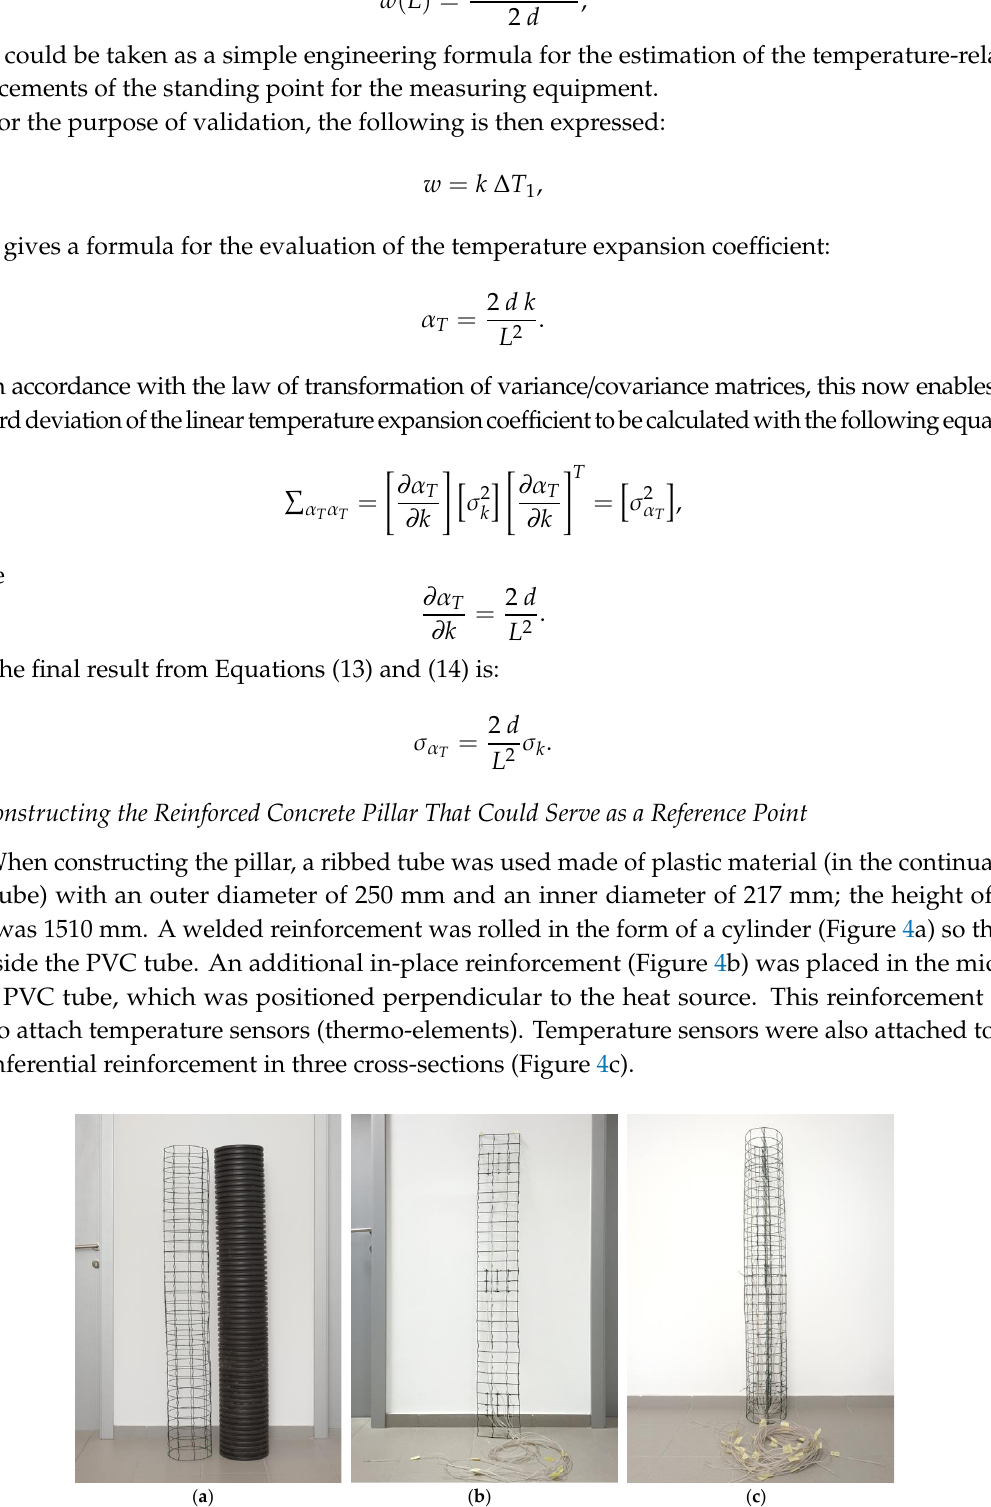
Figure 4. ( a ) The reinforcement rolled in the form of a cylinder and the PVC tube; ( b ) The reinforcement in the form of a plain mesh with the attached temperature sensors; ( c ) PVC tube and temperature sensors ready to be covered in concrete.